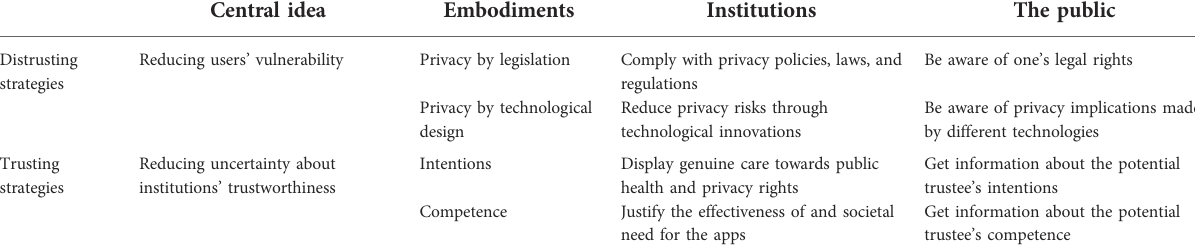
TABLE 2 A framework for the two sorts of strategies in the case of digital contact tracing. Central